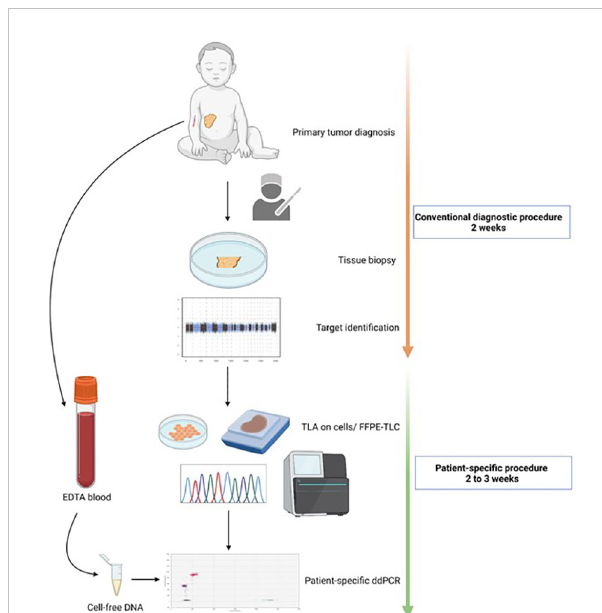
Supplemental Table S1. For TLA, PCR products were